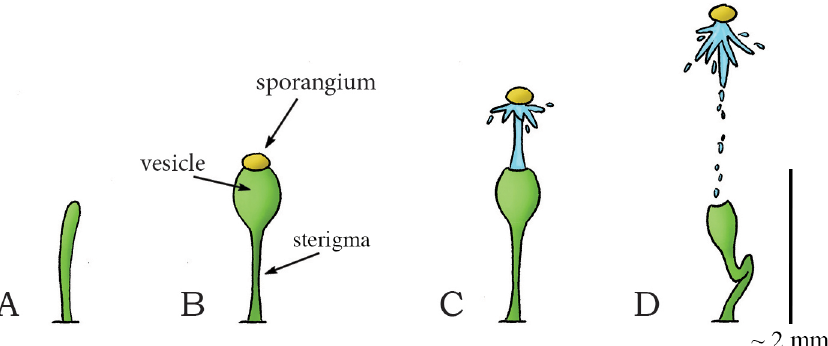
Fig 4. Fluid pressure catapult mechanism in the zygomycete Pilobolus kleinii . (A) Early stage of sporangiophore growth in P . kleinii . (B) Sporangiophore development showing the sterigma (stalk), balloon- like vesicle, and the sporangium at the tip. (C) When a critical pressure (of about 0.55 MPa relative to ambient) is reached, the sporangium breaks free from the sporangiophore and is propelled forward by a cell sap jet that is powered by the contracting vesicle wall. (D) Collapse of the sporangiophore after discharge of the sporangium. Drawings based on high-speed video images in [54]. Scale bar 2